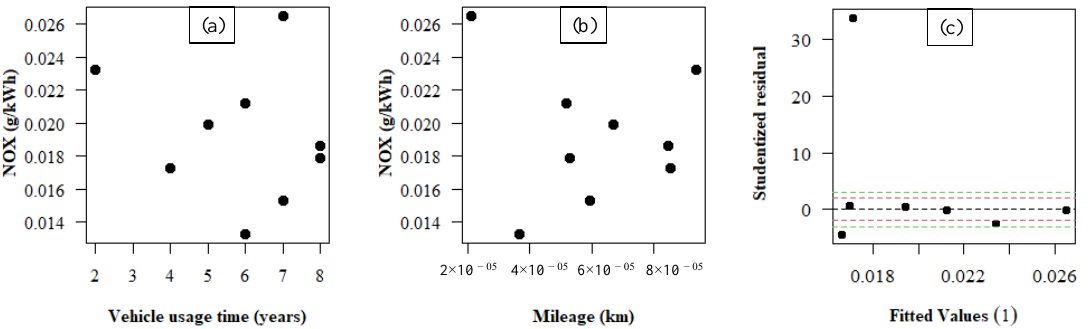
Figure 6. NO x fugitive emission behavior—adjustments of mileage-time relationships using a degree- 2 polynomial. ( a ) First individual fit using equation 9 with mileage as the explanatory variable; ( b ) Second individual fit using equation 9 with time of use as the explanatory variable; ( c ) The third and last adjustment using all terms of the polynomial equation of degree 2 analyzed the correlation between the explanatory variables (mileage and time of use). There was no acceptable correlation and no adjustment to the model was